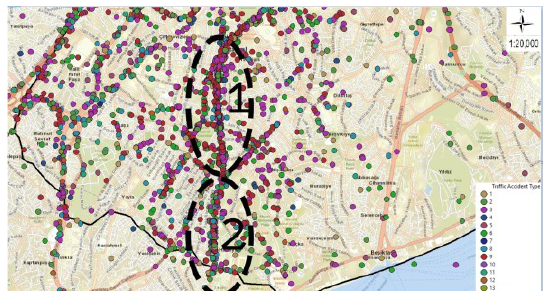
Figure 7. Representation of the 2 separated regions of traffic accidents in Şişli district. Figure 7 sho ws the division of the parts of Şişli district outside of Büyükdere Street into regions. The separation of Büyükdere Street was also examined as the 3rd region. The decomposition is as follows;